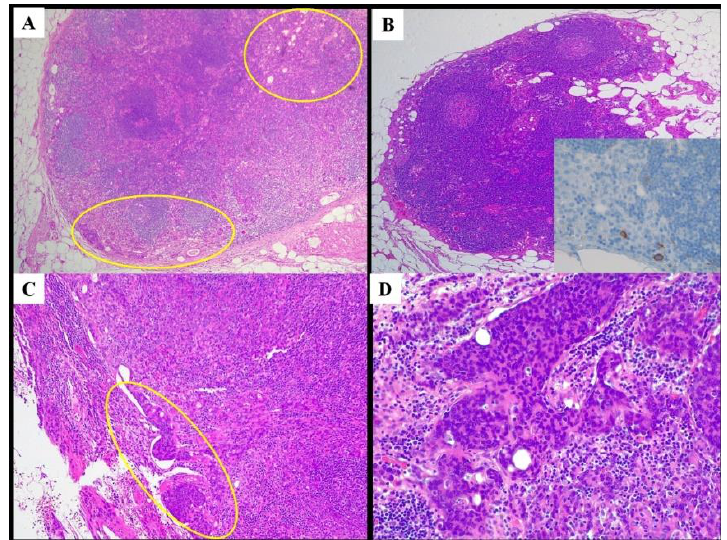
Figure 2. Metastatic lymph nodes. ( A ): one of the smallest metastatic lymph nodes (maximum di- ameter 1 mm), showing diffuse involvement (encircled). ( B ): isolated tumor cells found in a 1.4 mm- sized lymph node. ( B , inset): immunohistochemistry highlighting neoplastic cells. ( C ): central lymph node metastasis (encircled). ( D ): skip metastasis in station number 7 by a patient with a lower antral tumor. A-D, hematoxylin and eosin stain; B, inset 8/18 cytokeratin stain. Original magnifica- tion: ( A , B ): 5×; ( C ): 10×; ( D ): 20×; ( B ), inset: 40×. The control group included 25 males and 25 females, the mean age at diagnosis was 74 years old (range: 37−92 years); 4 patients underwent urgency surgery for occlusive or bleeding disease; 5 patients were subjected to neoadjuvant chemotherapy according to the FLOT regimen. The majority of tumors ( n = 30, 60%) were located in antral region, and were represented by low-grade ( n = 19, 61%) [15], tubular moderately differentiated ade- nocarcinoma ( n = 14, 28%) [21], intestinal type ( n = 18, 36%) according to Lauren [23], tub- ular 2 (tub2) ( n = 14, 28%) following JGCA classification [24]. Six patients suffered from early gastric cancer. Most of patients had a pT3 tumor ( n = 30, 60%), with only 3 metastatic cases. The most frequent stage according to the TNM VIII [6] and the AJCC 2017 [7] was IIIA ( n = 10, 20%) (Table 3). Table 3. Clinicopathological features, morbidity and mortality of control group patients.